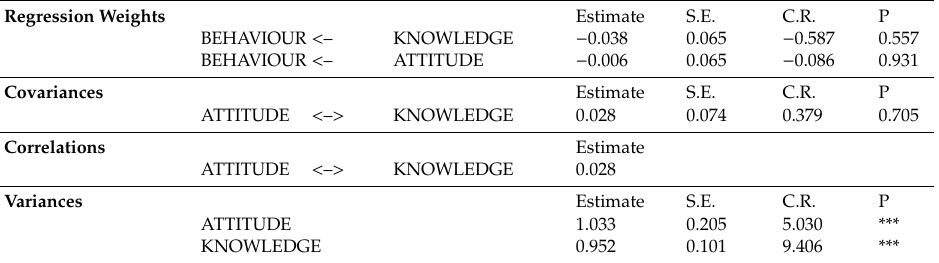
Table 5. Estimates / scalar estimates / maximum likelihood estimates.